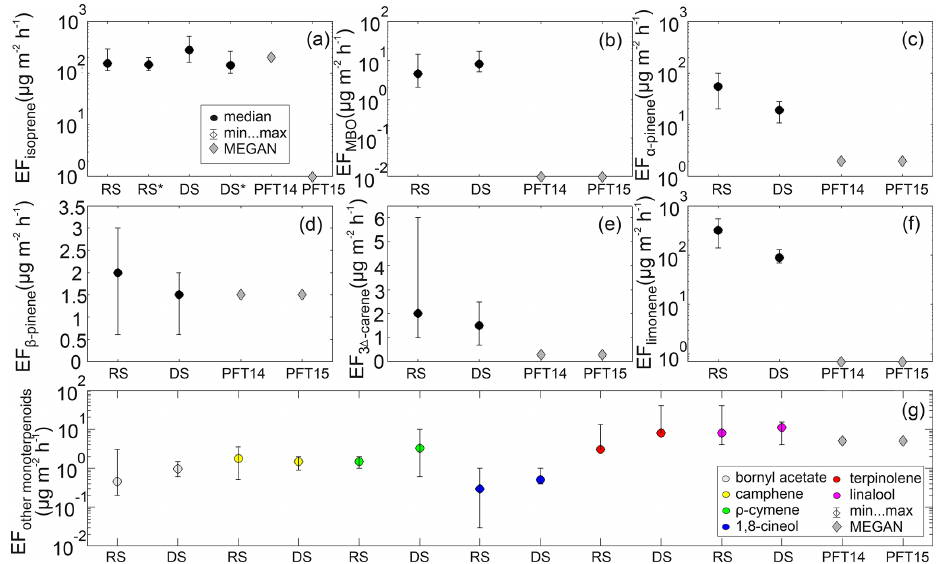
Figure 7. Estimated biogenic volatile organic compound (BVOC) emission factors (EFs) for the agriculture savanna ecosystem surrounding the Maktau field site in comparison with the EFs for warm C 4 grass (PFT14) and Crop1 (PFT15) used in MEGAN v2.1. The EFs have been estimated for the rainy season (RS; April) and for the dry season (DS; September) separately. (a) Isoprene (the EF was estimated by either considering RS or DS or neglecting RS ∗ or DS ∗ , which is a dependency of the activity factor on soil moisture availability), (b) 2-Methyl-3- buten-2-ol, (c) α -pinene, (d) β -pinene, (e) 3 (cid:49) -carene, (f) limonene, and (g) other monoterpenes, which includes the sum of up to 34 other monoterpenes in MEGAN v2.1 and includes bornyl acetate (gray), camphene (yellow), ρ -cymene (green), 1,8-cineol (blue), terpinolene (red), and linalool (magenta) at Maktau Weather Station. The legend provided in panel (a) is valid for panels (a) to (f) .